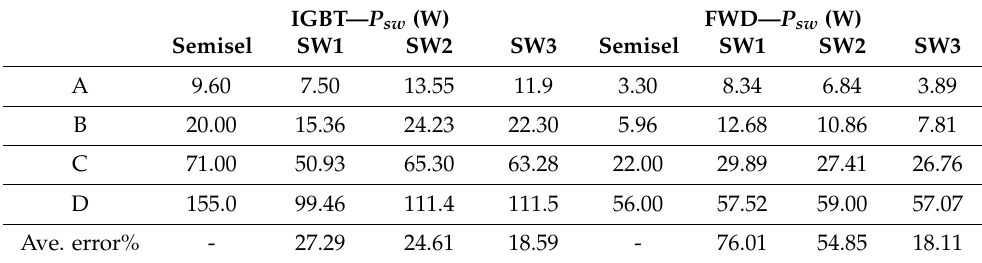
Table 8. Switching losses comparison, V DC = 500 V.